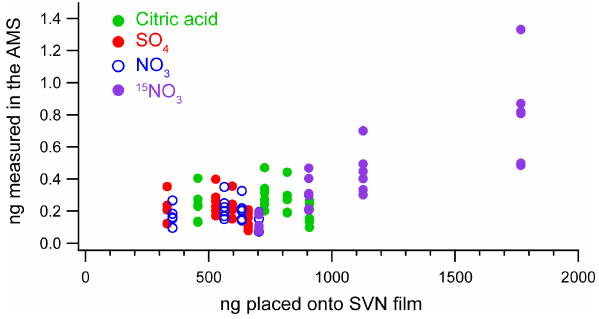
Figure 3. Mass of each component placed on the thin film vs. the mass measured by the AMS for four different solutions with varying concentrations of citric acid, ammonium sulfate, ammonium nitrate, and the internal standard (NH 15 NO 3 ), all with a total solution con- 4 centration of 0.75gL − 1 . Each sample had five replicate injections, with the vertical spread in the measured masses indicating substan- tial run-to-run variability (up to a factor of 3) among